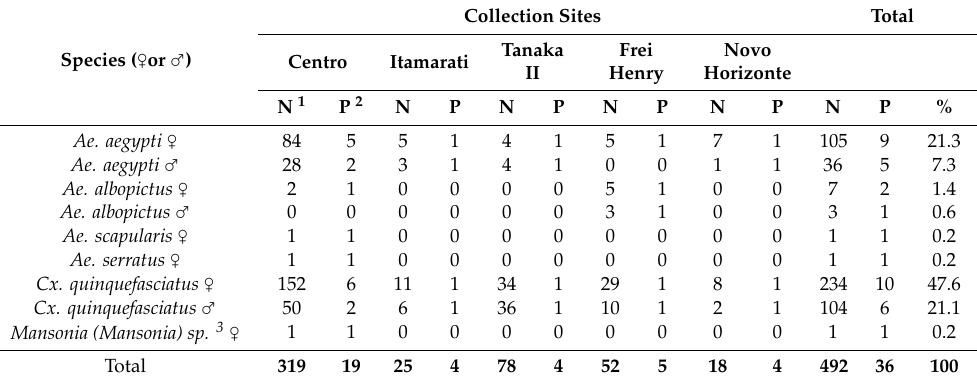
Table 1. Distribution of mosquitoes according to species, sex and the collection site in Xinguara, Par á during an outbreak of chikungunya, 2017.